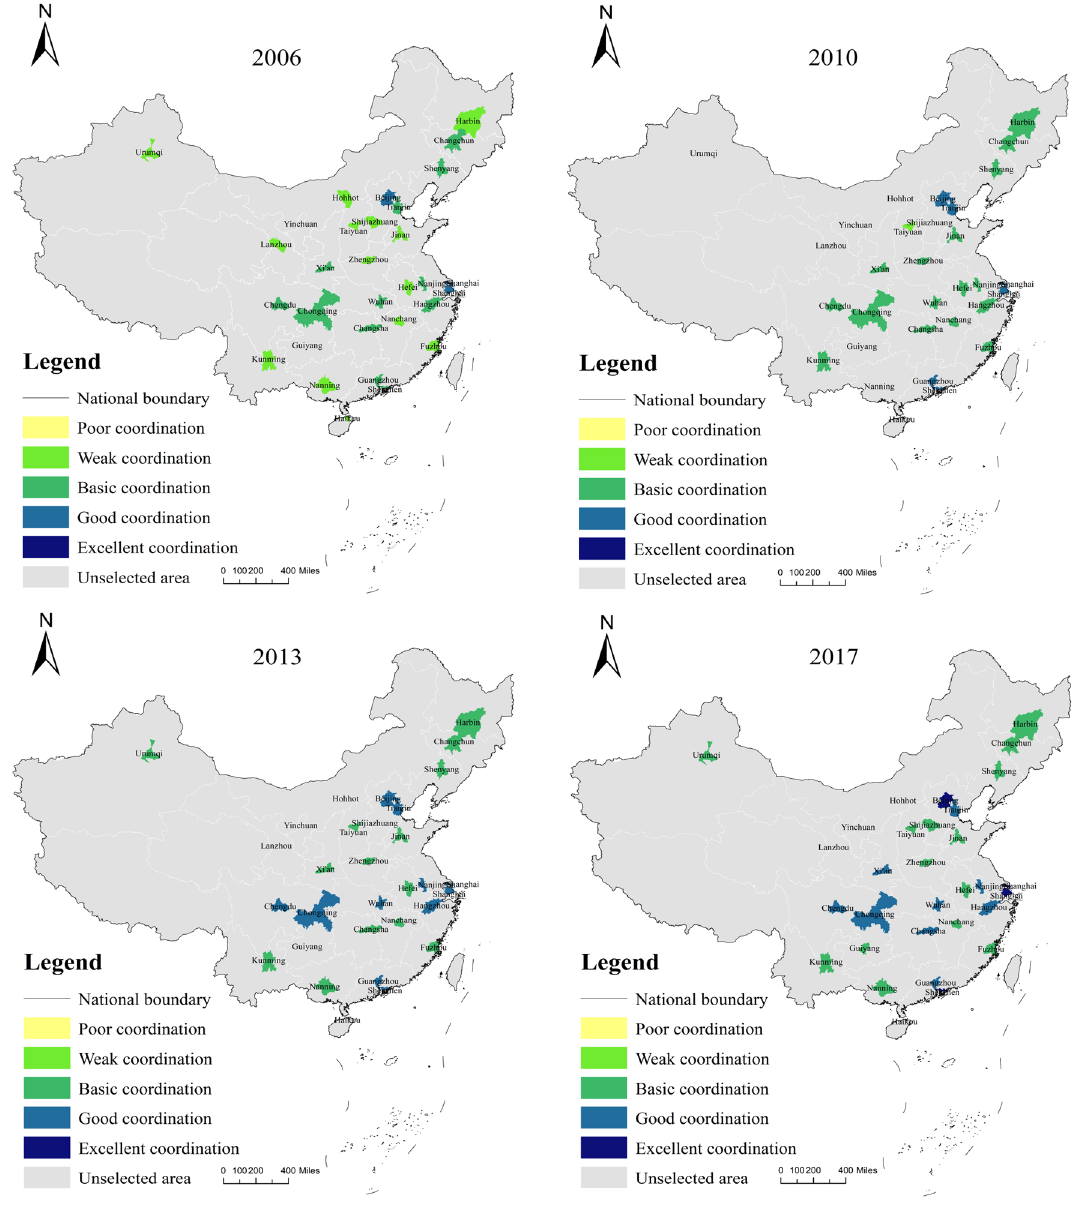
Figure 7. CCD of low-carbon-economic